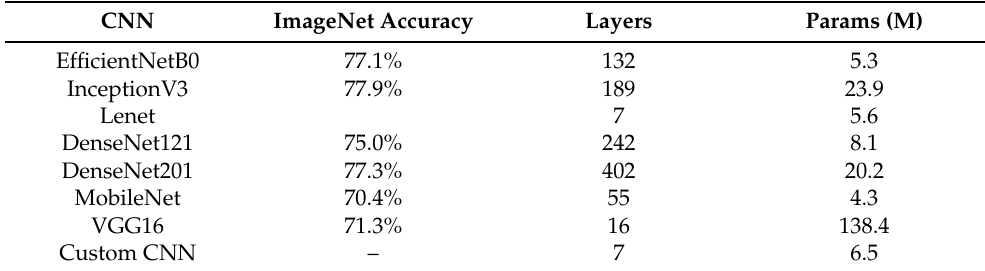
Table 1. State-of-the-art CNN models